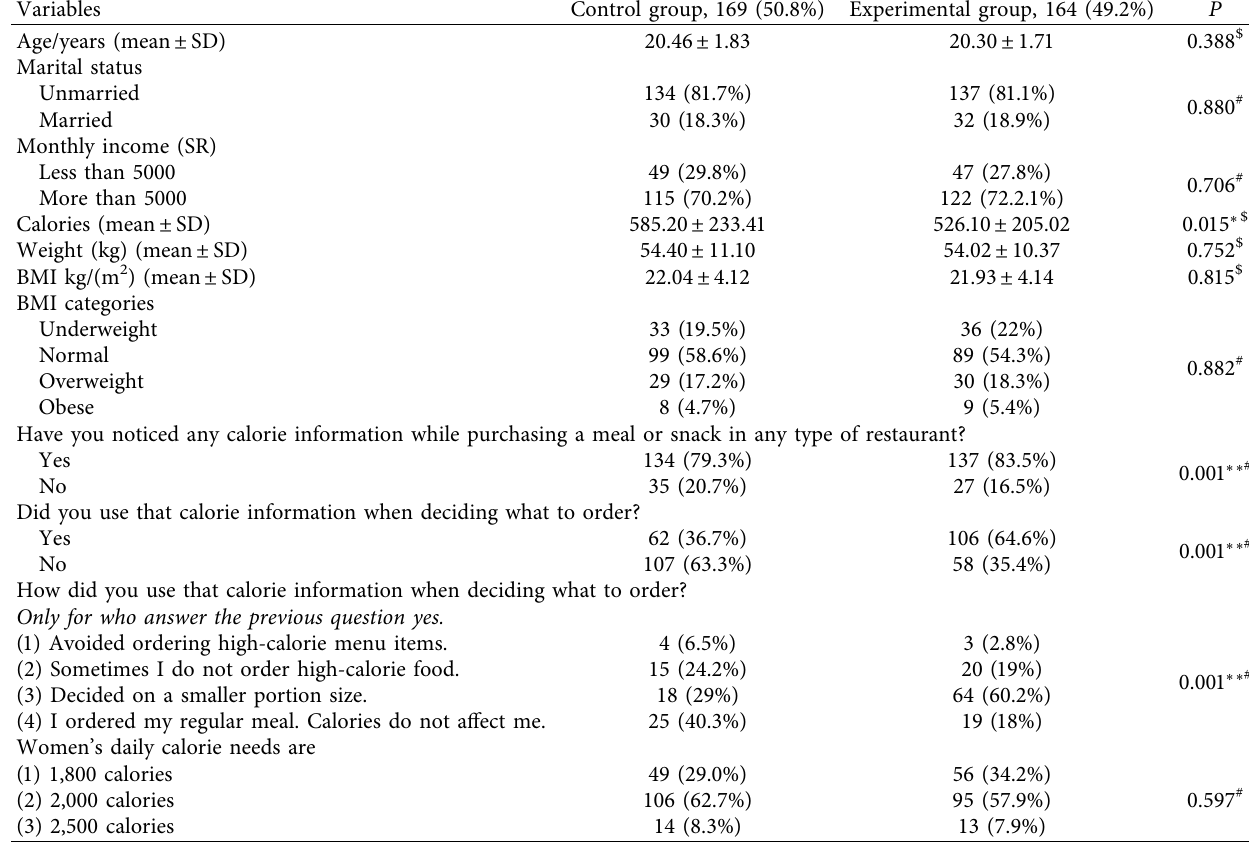
Table 1: Calories, anthropometric measurements, calorie information, weight concern, weight perception, and weight-control behaviors in the two groups ( N �